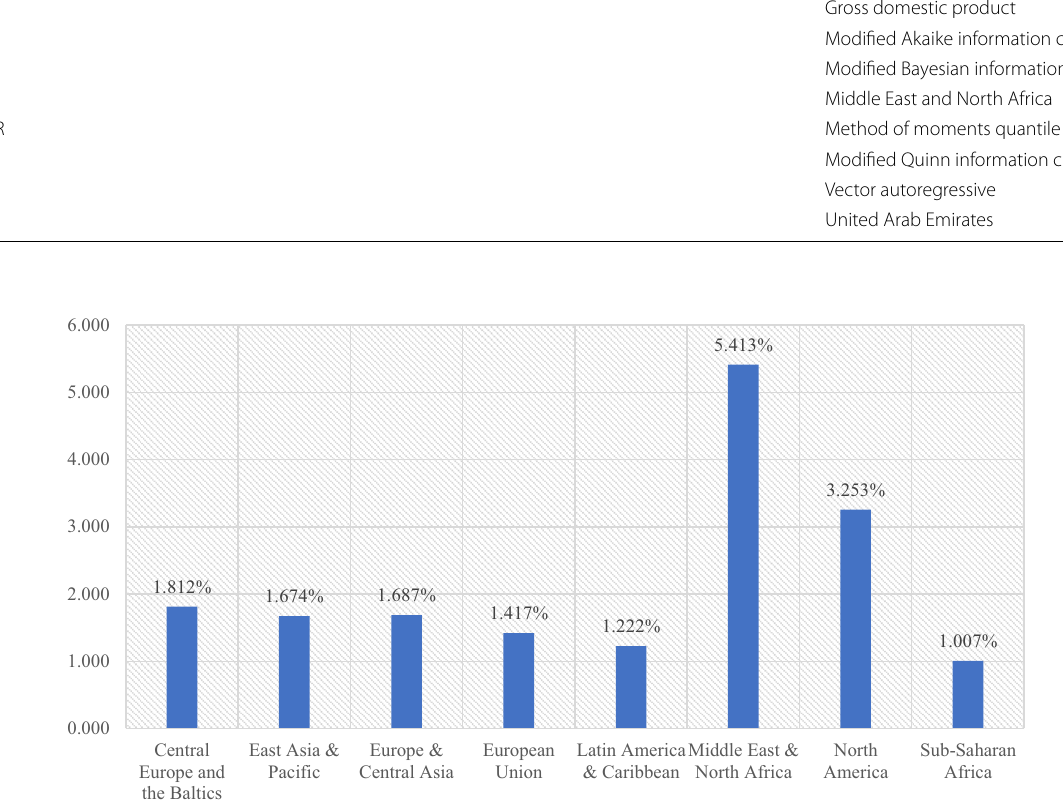
Fig. 13 Military expenditure as a percentage of GDP (%)